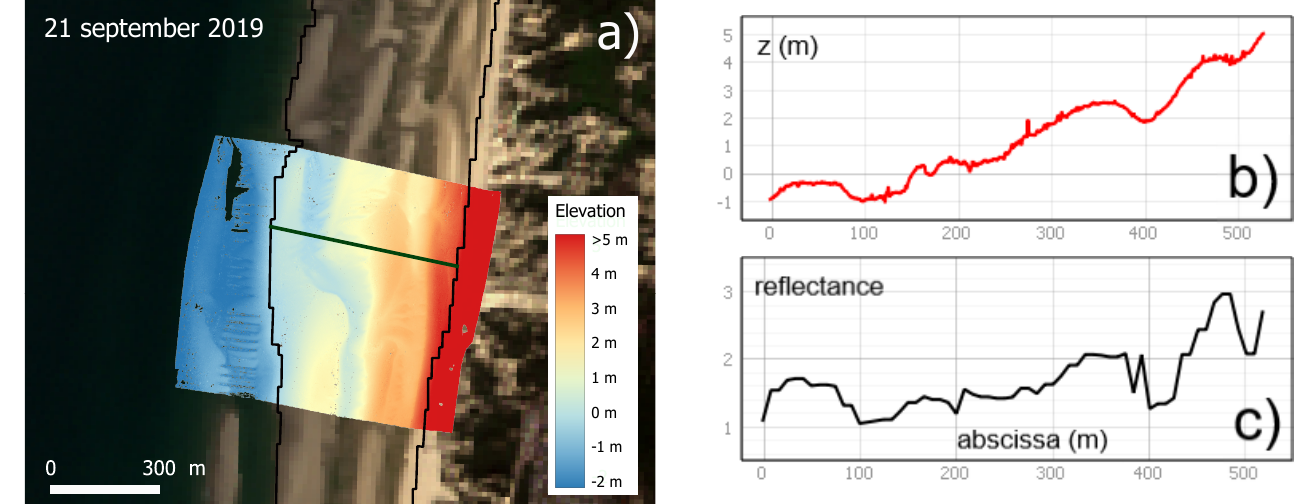
Figure 3. ( a ) DEM constructed from the observations, superimposed on a Sentinel-2 image of the Berck shoreline site. The intertidal zone is delimited by the black lines and the chosen transect is for the comparison of the elevation profile of the beach from west to east ( b ) with the dimensionless B03 reflectance of the multi-spectral Sentinel-2 image ( c ).